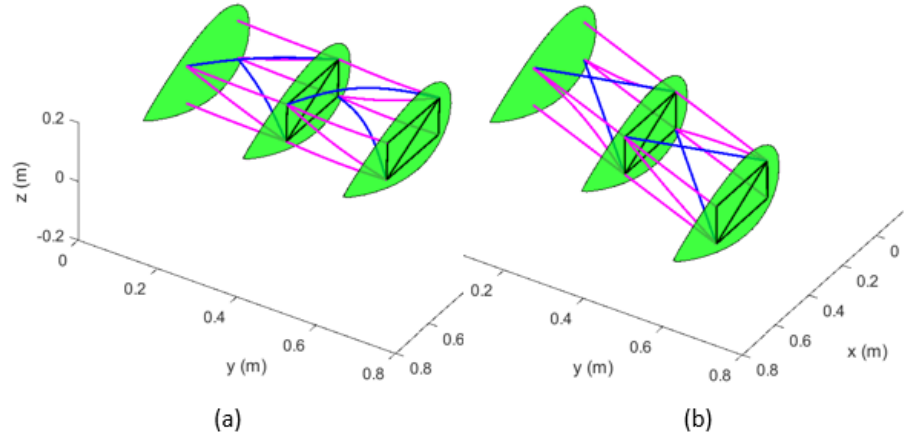
Figure 17. Ninth mode shape for the system in the ( a ) un–morphed configuration, ( b ) morphed configuration (simulation 25).